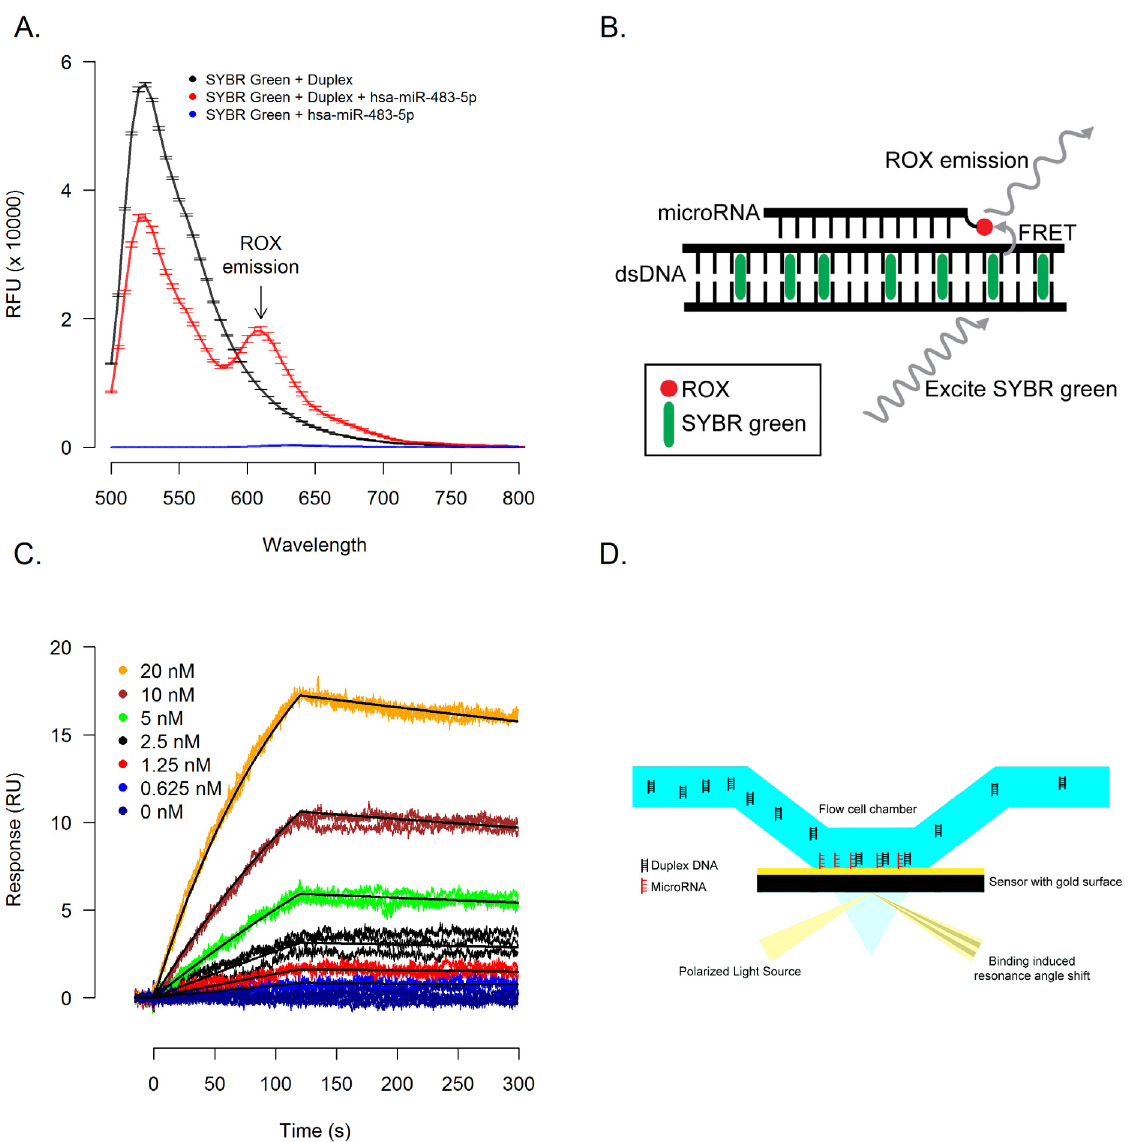
Fig 3. MicroRNAs form triplex structures with DNA. (A) Duplex DNA identified by genome-wide screens of binding sites was incubated in presence or absence of a synthesized hsa-miR-483-5p with a 3 ’ ROX label to perform a FRET assay to detect triplex formation (illustrated in 3B ). In the absence of ROX labeled hsa-miR-483-5p ( 3A , black line) a single emission peak at 520nm is observed which, with the addition of ROX labeled hsa-miR-483-5p ( 3A , red line), is diminished and a second FRET induced emission peak at 610nm is observed. (C) In a complementary surface plasmon resonance (SPR) based assay (illustrated in 3D ), a 3 ’ biotin labeled hsa-miR-483-5p was immobilized and duplex DNA was introduced in triplicate in a 2-fold dilution series starting at 20